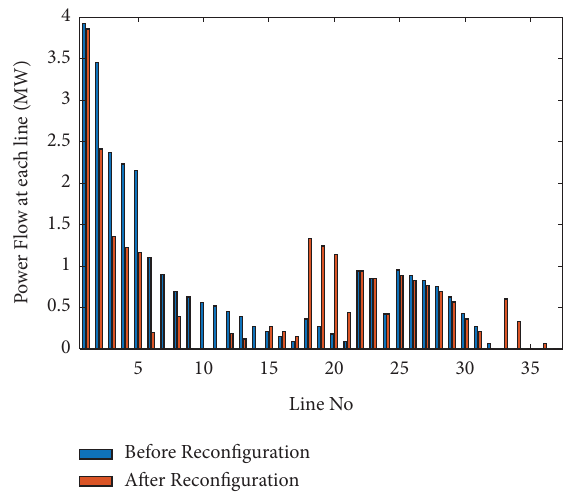
Figure 8: Power fow at each line in 33-bus system normal load before and after